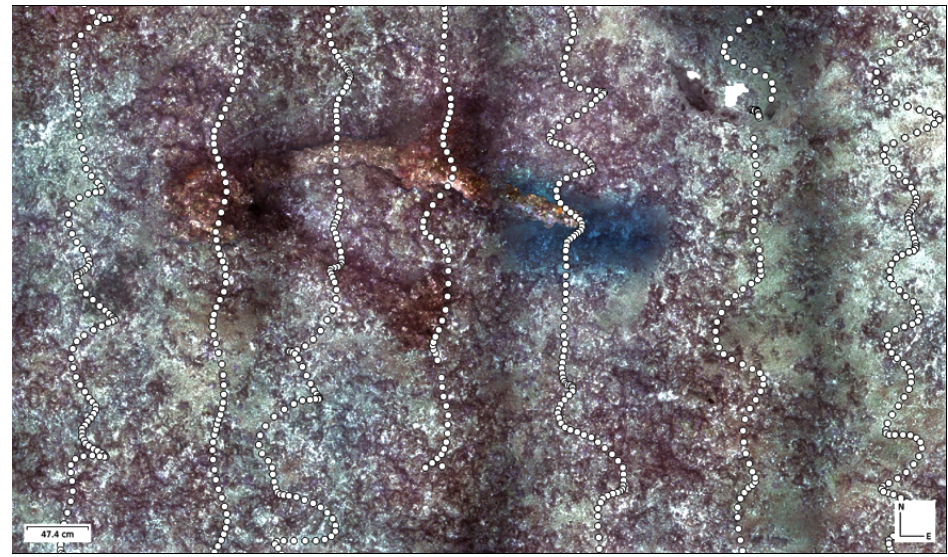
Figure 31. Close-up of the mosaic in Figure 26, right, acquired at Achziv, along the northern section of Israel’s Mediterranean coast. It depicts a part of a shipwreck lying a rocky reef. The AUV’s path is depicted using white dots.